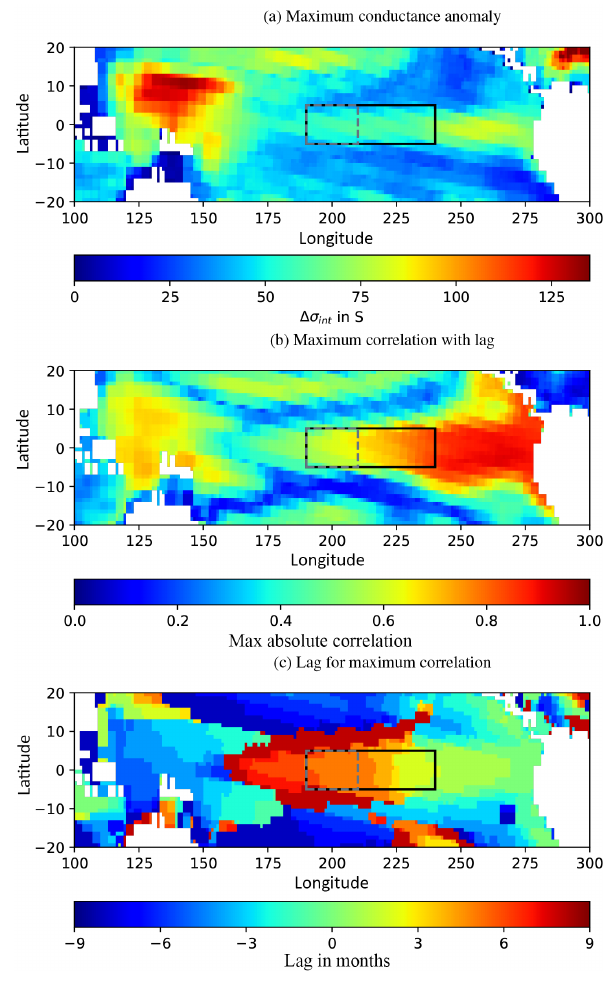
Figure 3. Cross-correlation analysis between the ONI and the con- ductance ( σ int ) at each grid point: maximum absolute conductance anomaly (a) , absolute maximum correlation, the peak value of the cross-correlation (b) , corresponding lead/lag to the absolute maxi- mum correlation (c) . The solid rectangle shows the location of the Niño 3.4 region, the dashed rectangle shows the location of an up- dated MaNI (5 ◦ N–5 ◦ S, 150–170 ◦ W).